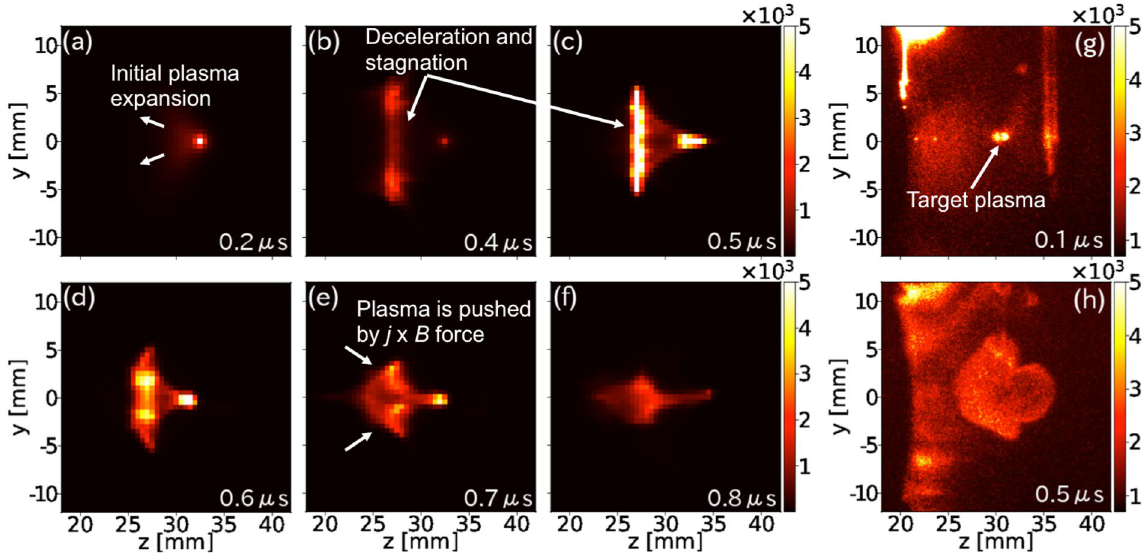
Figure 5. Artificial camera images generated from numerical simulation with four-coil operation at ( a ) t = 0.2 μ s, ( b ) 0.4 μ s, ( c ) 0.5 μ s, ( d ) 0.6 μ s, ( e ) 0.7 μ s, and ( f ) 0.8 μ s outside of the coil. The camera images at ( g ) t = 0.1 μ s and ( g ) 0.5 μ s obtained from the experiment are shown as